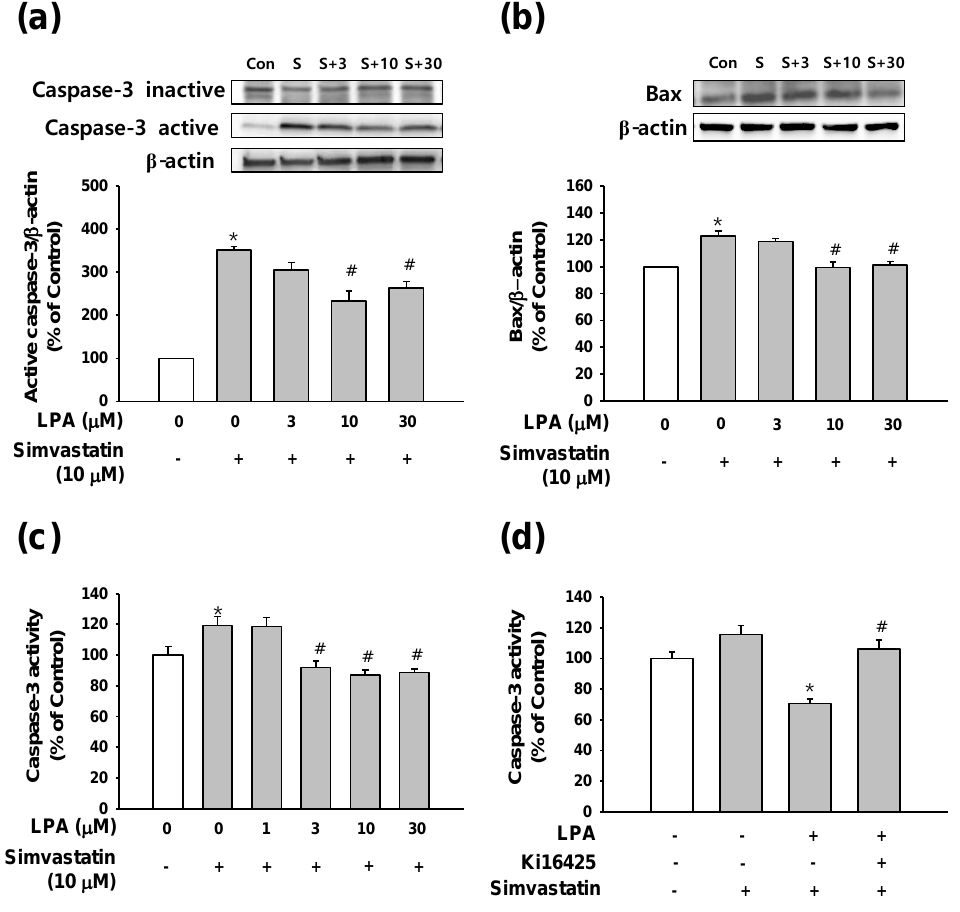
Figure 3. Effect of LPA on apoptosis-related proteins in simvastatin-treated L6 cells. Effect of LPA on the simvastatin-induced caspase-3 activation ( a ) and Bax expression ( b ) in L6 cells. Cells were serum- starved for 6 h and then treated with LPA (0 –30 μM) in the presence of simvastatin (10 μM) in serum free medium for 48 h. Cell lysates were subjected to immunoblotting with the indicated antibodies (n = 4 for each antibody) ( a,b ). ( c,d ) Effect of LPA on simvastatin-induced caspase-3 activity ( c ) and effect of LPA receptor inhibitor on LPA-reduced caspase-3 activity ( d ) in L6 cells. Cells were treated with LPA at indicated concentrations in the presence of 10 μM of simvastatin for 5 h (n = 6) ( c ). Cells were incubated with or without LPA receptor inhibitor Ki16425 (5 μM) in the presence of LPA (10 μM) or simvastatin (10 μM) in serum free medium for 5 h (n = 6) ( d ). Cellular caspase-3 activity was measured as mentioned in the Materials and Methods section. Data represent the means ± SEM. Levels in untreated controls were considered as 100%. (a – c) * p < 0.05 vs. untreated control; # p < 0.05 vs. simvastatin alone. ( d ) * p < 0.05 vs. simvastatin alone; # p < 0.05 vs. LPA with simvastatin. Immunoblot bands: S, simvastatin ( 10 μM ); S+3, simvastatin ( 10 μM )+LPA (3 μM ); S+10, simvastatin ( 10 μM )+LPA (10 μM ); S+30, simvastatin ( 10 μM )+LPA (30 μM ). 2.4. Involvement of LPA Receptor and PKC in the Protective Effect of LPA on Simvastatin-Induced Cytotoxicity To determine signaling pathways associated with LPA’s action on L6 cell response in the presence of simvastatin, the effect of LPA on simvastatin-induced L6 cell toxicity was tested in the presence or absence of LPA receptor inhibitor Ki16425 or PKC inhibi tor GF109203X. LPA (10 μM) - induced inhibition of L6 cell viability reduction in the presence of simvastatin was completely blocked by treatment with Ki16425 (5 μM) ( Figure 4a). Treatment with GF109203X (1μM) showed similar pattern to the effect of Ki16425 (5 μM) on LPA and simvastatin -induced cell viability (Figure